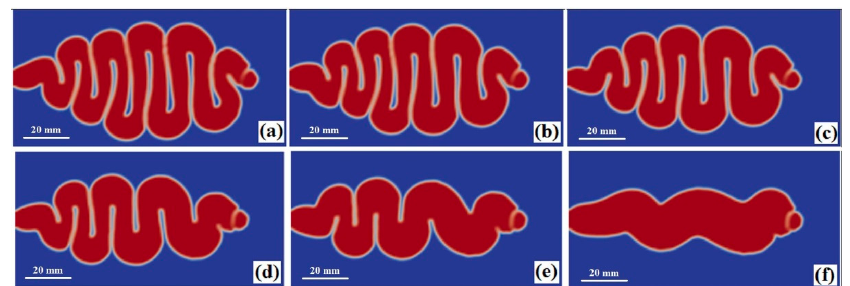
Figure 5. Buckling flow shapes at the end of jetting at melt temperatures ( a ) 235 °C (1.55 s); ( b ) 245 °C (1.45 s); ( c ) 255 °C (1.35 s); ( d ) 265 °C (1.2 s); ( e ) 275 °C (1.1 s); and ( f ) 285 °C (0.95 s).